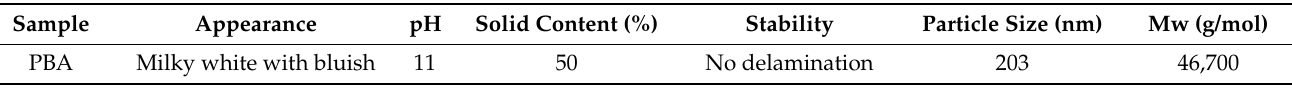
Table 3. Basic physical information of polymer emulsions.